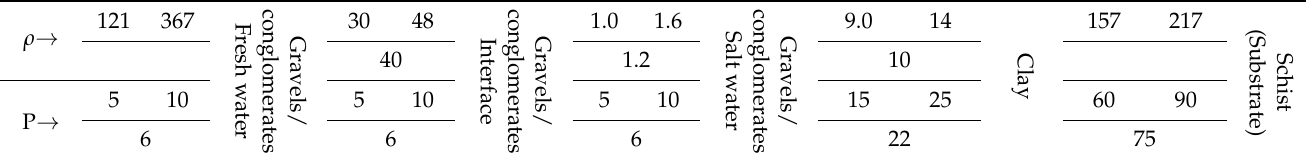
Table 3. Resistivity and polarisability ranges used for lithological assignment and mean values when applicable.